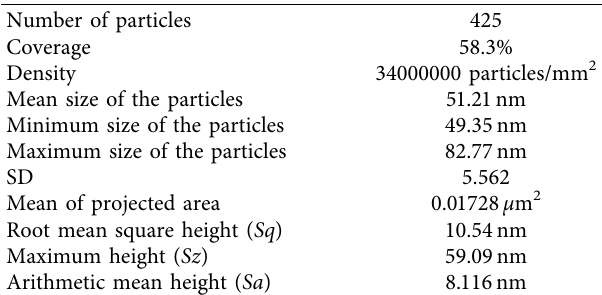
Table 1: Te AFM grain statistics for the prepared CHX-HMP